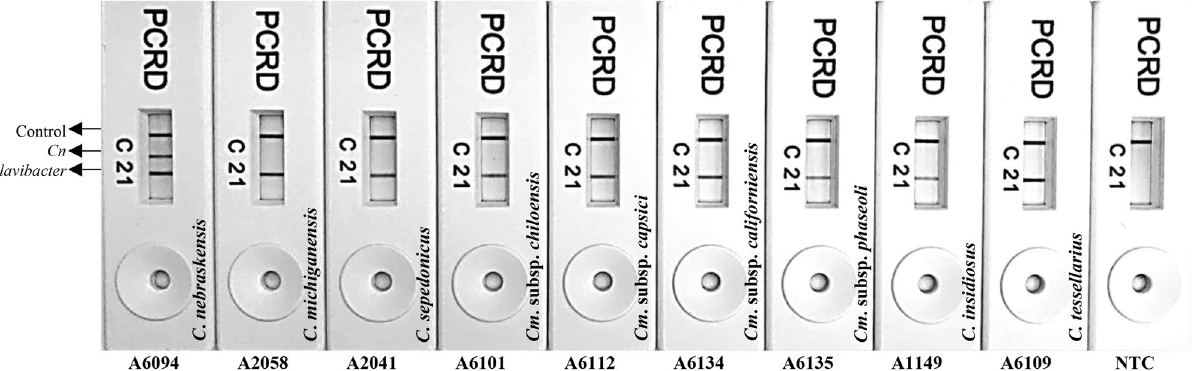
Figure 3. Multiplex RPA assay validation with all known species within the genus Clavibacter . PCRD Nucleic Acid Detector allows the detection of labeled RPA amplicons: line 1- detects the nine DIG/Biotin-labelled Clavibacter species/subspecies amplicons; line 2 -specific detection of FAM/Biotin-labeled C. nebraskensis amplicons, and; line C—control line. NTC (non-template control; water) is included in the last reaction. Strain numbers and species/subspecies names are provided in the